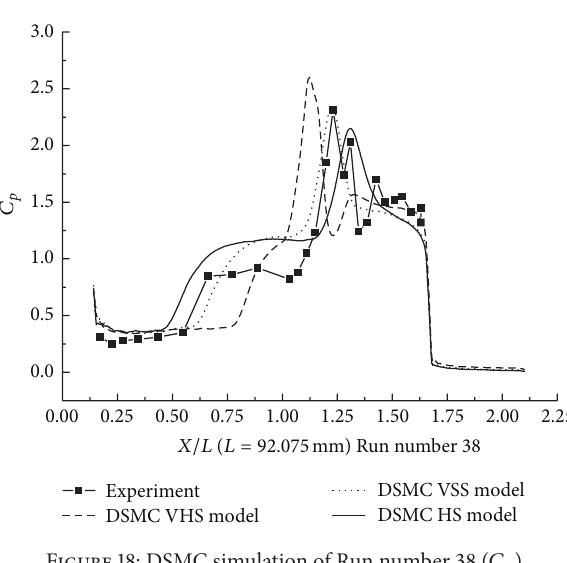
Figure 18: DSMC simulation of Run number 38 ( 𝐶 𝑃 ).